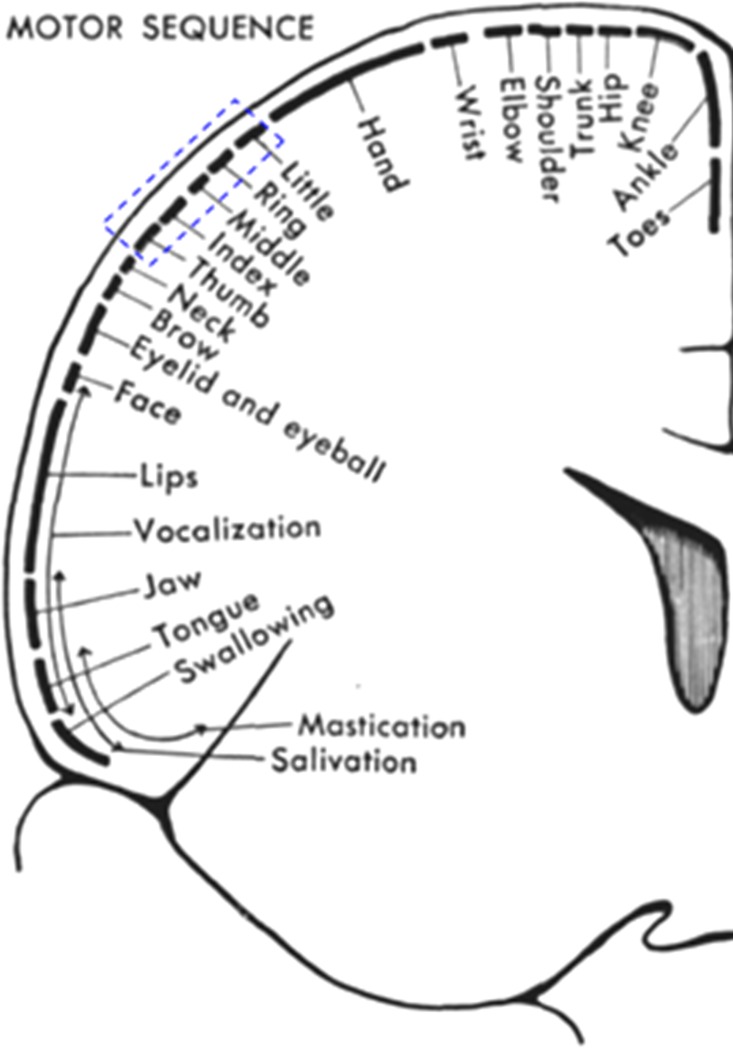
Brain regions of fingers directly detected by electrocorticogram in the motor cortex (blue dashed rectangle), see Fig 9 in [41].